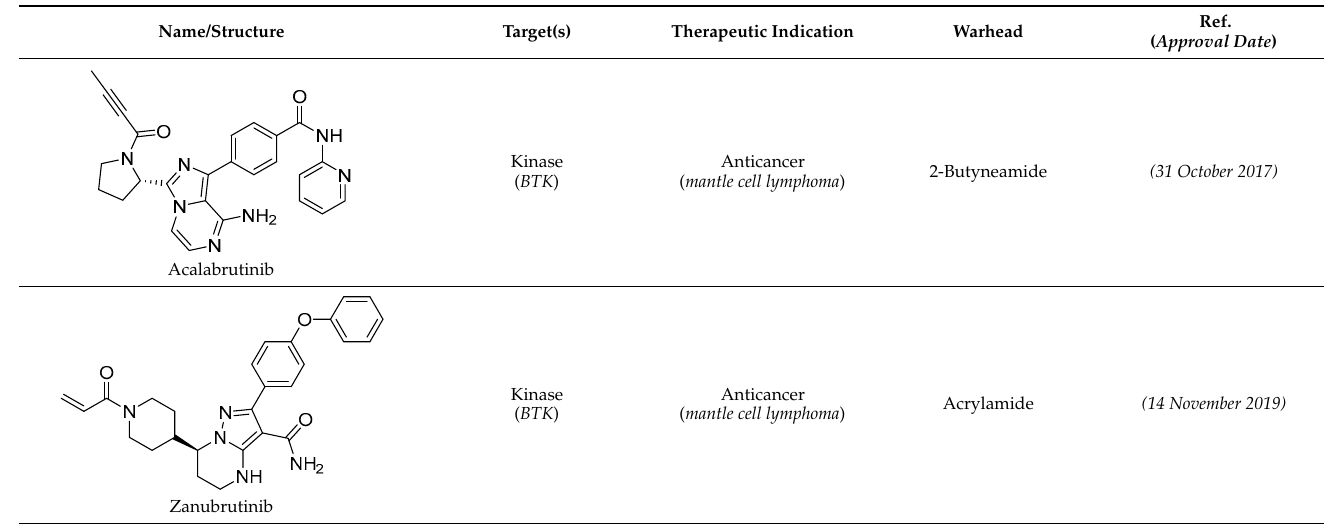
Table 2. Representative examples of targeted covalent inhibitors.